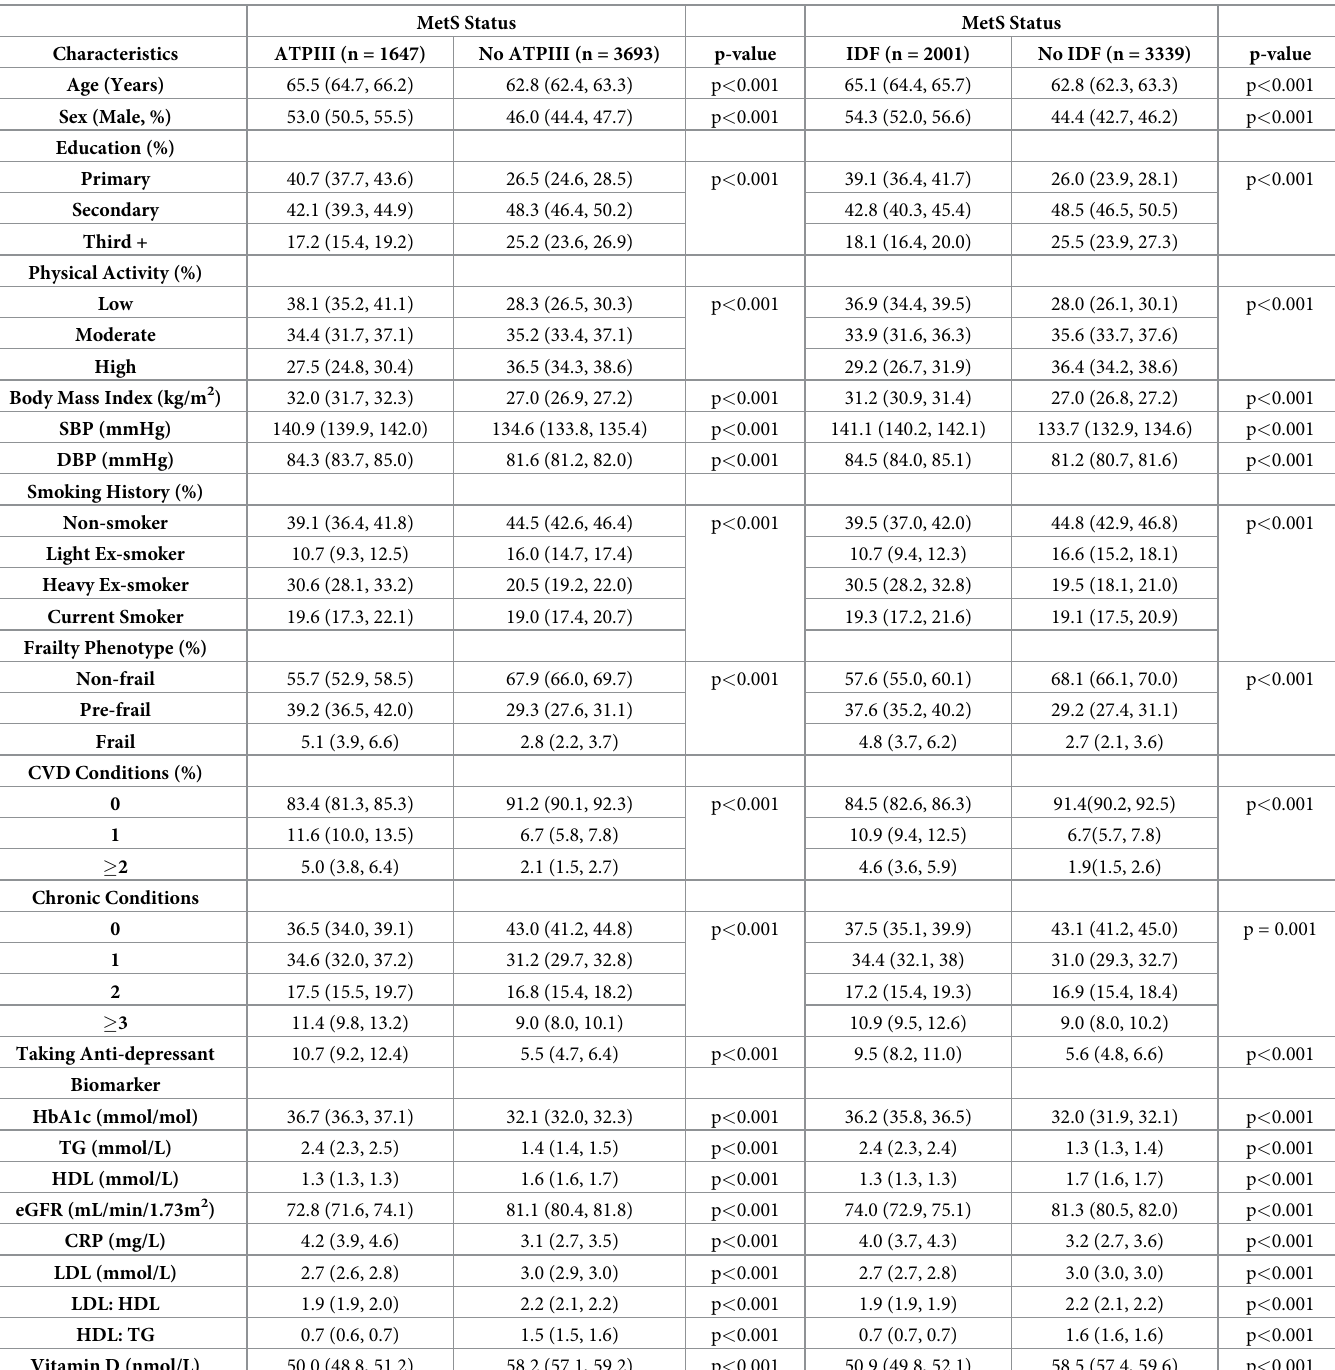
Table 4. Weighted characteristics of those with metabolic syndrome (MetS) compared to those without MetS. MetS